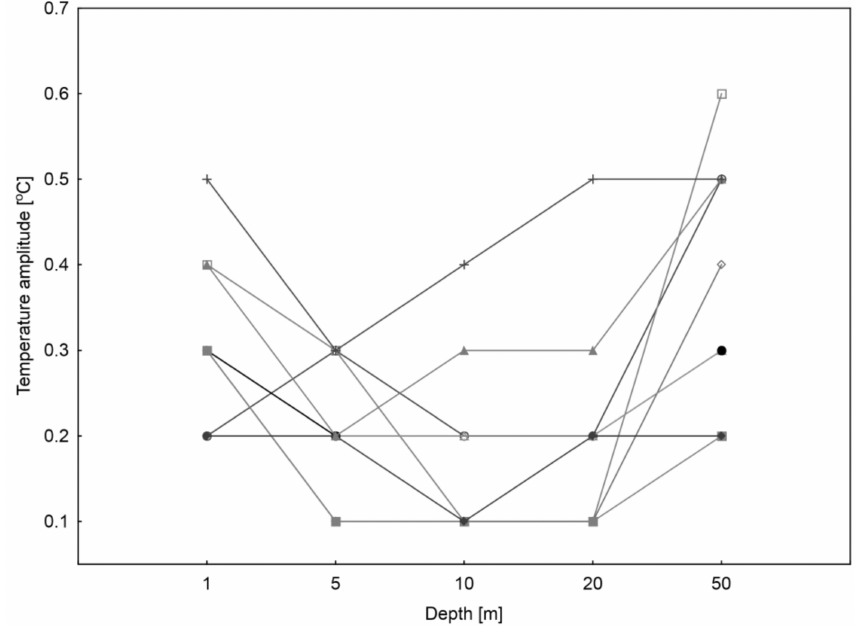
Figure 11. Correlation between water temperature amplitude and depth in Lake Morskie Oko. Temperature profile Type 6. The dates for each line are described in detail in the text above. Changes in mean daily water temperature amplitudes at a depth of 1 m, as well as mean daily air temperature and wind velocity are presented in Figures 12 and